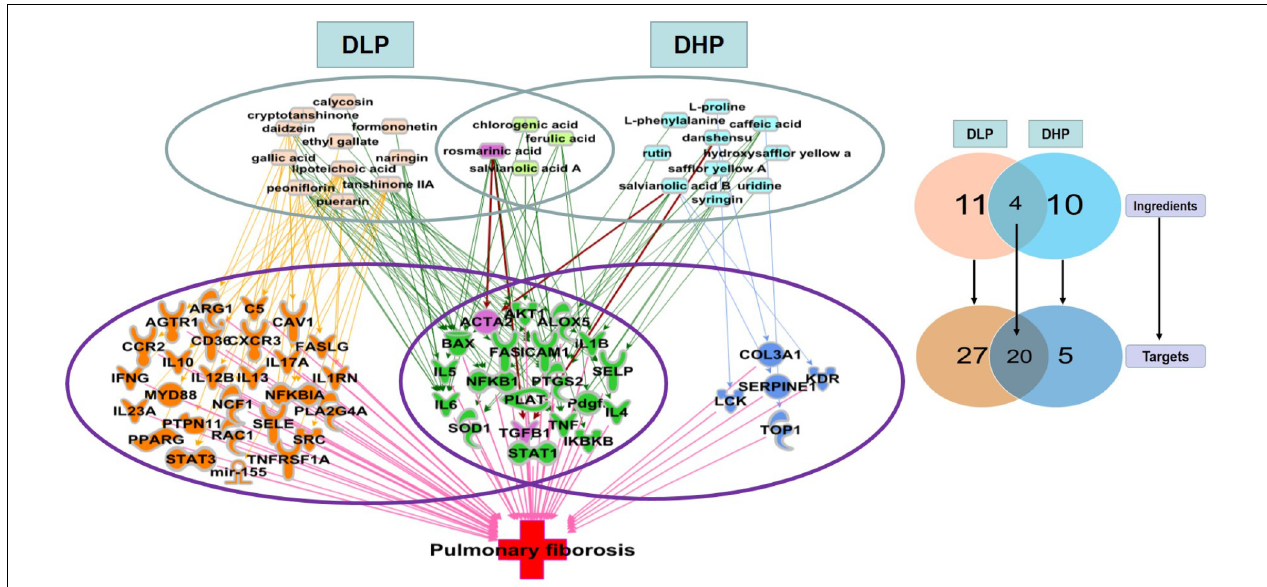
FIGURE 6 | Unique and shared pulmonary fibrosis-related targets regulated by DLP and DHP. Fifteen DLP major ingredients (pink), 14 DHP major ingredients (blue), and four shared ingredients from these two prescriptions (light green) were represented, which cooperatively modulate 52 common intracellular targets. Among these 52 pulmonary fibrosis-related targets, 27 unique targets regulated by DLP (orange) and 5 unique targets regulated by DHP (dark blue) with 20 targets shared by both